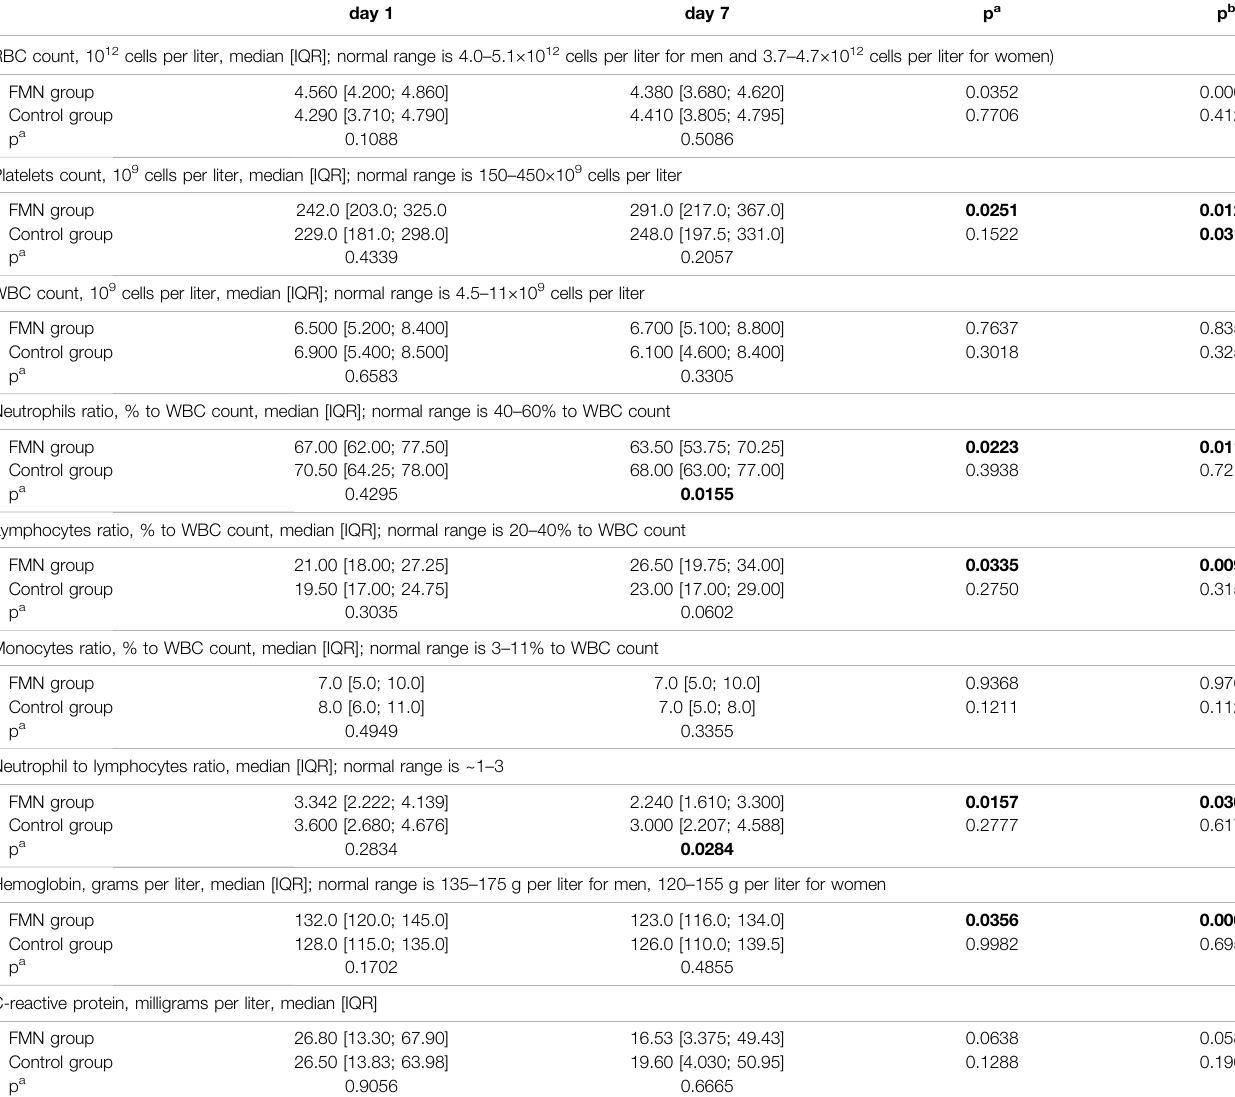
TABLE 4 | Dynamics of main blood and biochemical parameters within 1 week after admission to the hospital for patients demonstrated CRP value > 10 mg/l and/or CT grade 2 – 4 at any time of treatment in FMN group ( n = 38) and control group ( n = 43). day 1 day 7 p a p b RBC count, 10 12 cells per liter, median [IQR]; normal range is 4.0 – 5.1×10 12 cells per liter for men and 3.7 – 4.7×10 12 cells per liter for